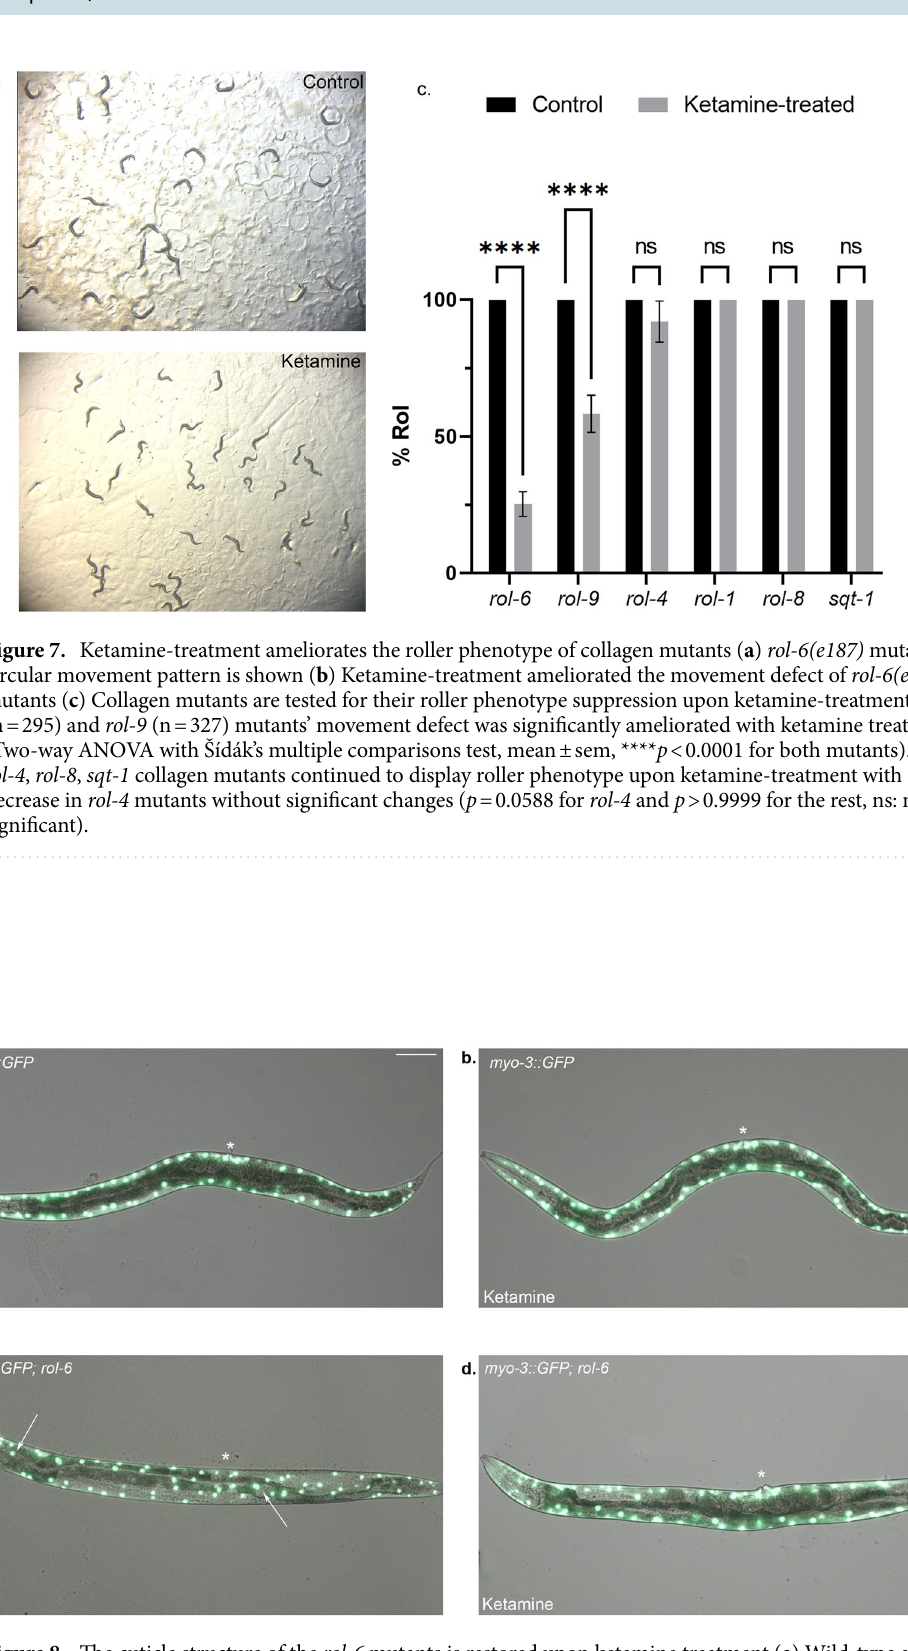
Figure 8. The cuticle structure of the rol-6 mutants is restored upon ketamine treatment ( a ) Wild-type animal expressing myo-3::GFP reporter construct in control and ( b ) ketamine-treated conditions. Body wall muscles are longitudinally oriented along the body of the worm. ( c ) rol-6(e187) mutant expressing myo-3::GFP reporter construct in control condition is shown. Arrows show the positions of the helical twist in the cuticle structure. ( d ) In ketamine-treated myo-3::GFP ; rol-6(e187) mutant, a wild-type like body wall muscle expression pattern is detected. Vulva is marked with an asterisk. Anterior is to the left. Scale bar shows 75 micron for all